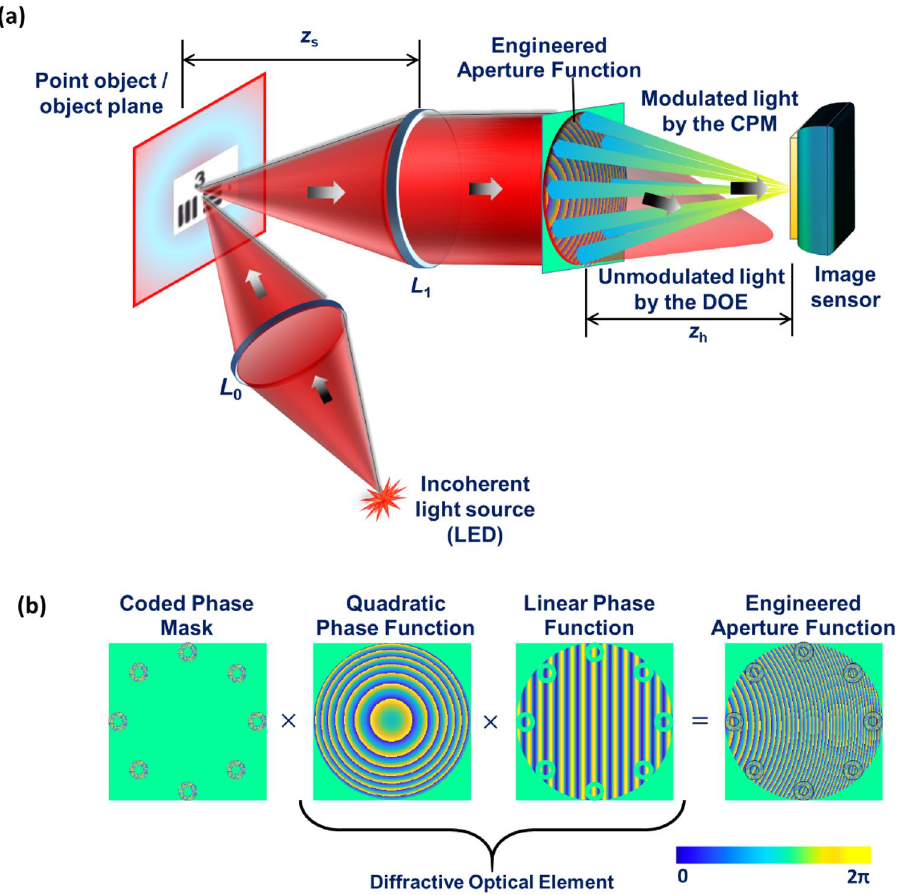
0 and L 1 —refractive lens; LED—light emitting diode and DOE—diffractive optical